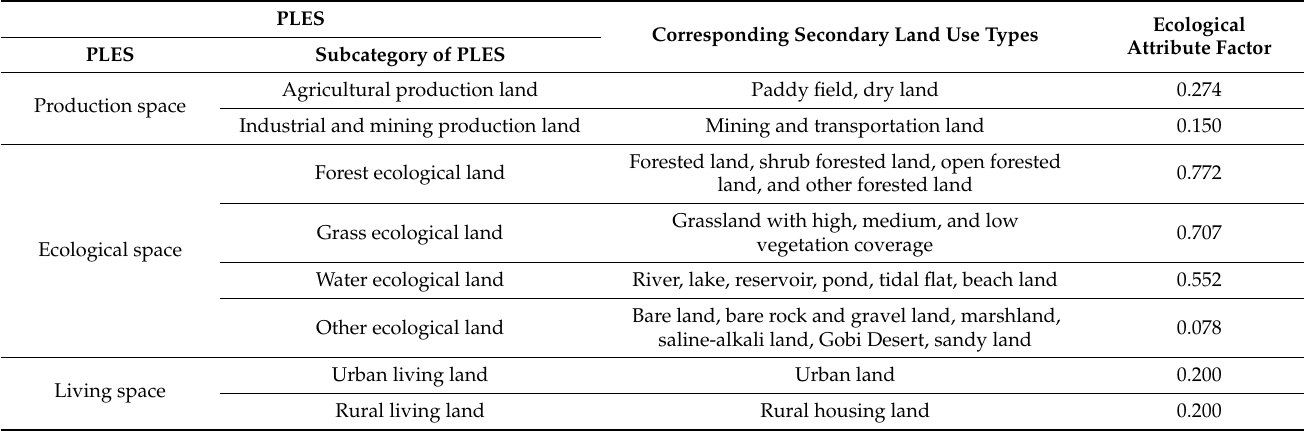
Table 1. Classification of PLES, corresponding secondary land use types, and their ecological at- tribute factors. PLES